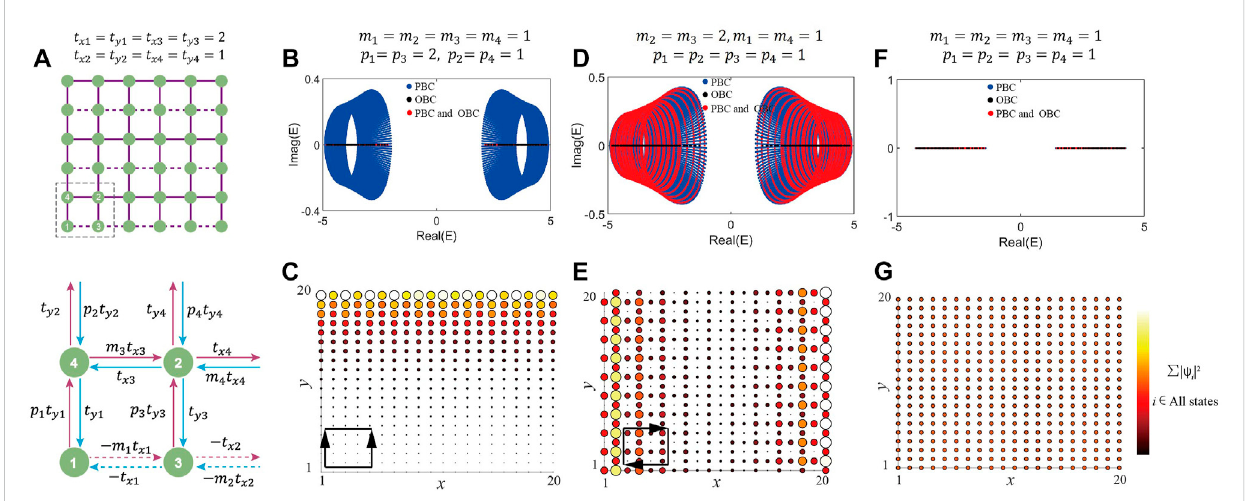
FIGURE 3 (A) Illustration of a 2D SSH-like lattice model with dashed box highlighting the primitive cell. The enlarged inset clearly shows the detail of non- reciprocal hoppings between NN sites. Positive and negative hoppings are denoted by solid and dashed lines. Under double PBCs (blue dots), double OBCs(blackdots)and y -OBC/ x -PBC(reddots),werespectivelyploteigenenergyinthecomplex-energyplanesforthreesetsofratiocoef fi cients[ (B)(D) (F) ]. Accordingly, the intensity pro fi les of all the eigenmodes are also respectively summed and plotted in sub fi gure (C) , (E) , and (G) with dots representing amplitude of skin mode intensity. The insets depict the forming mechanism of skin modes.